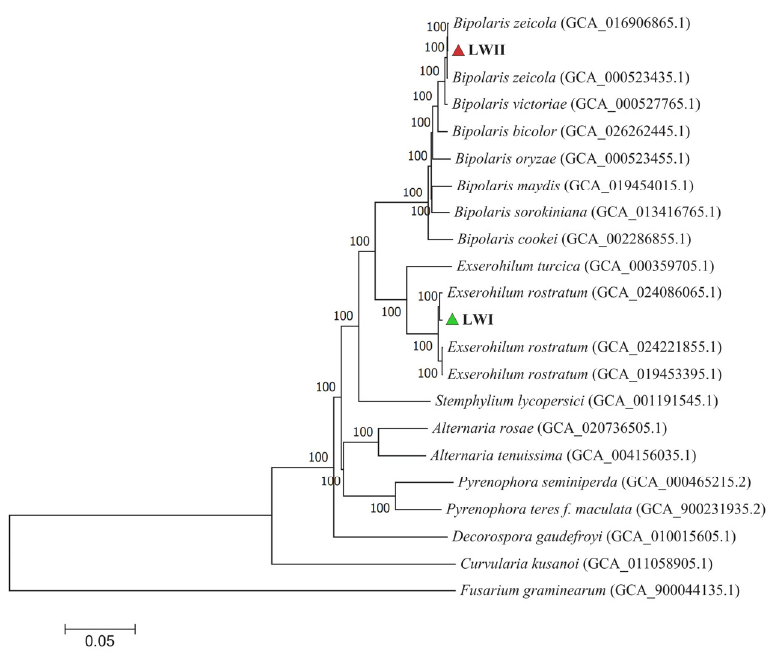
Figure 10. The phylogenetic relationship between E. rostratum LWI and B. zeicola LWIIwas constructed based on phylogenetic trees of the gene family analysis. There were 2072 single-copy homologous genes. The Bootstrap value indicates the confidence level of the branch in the phylogenetic tree. The triangular symbols indicate the positions of E. rostratum LWI (green) and B. zeicola LWII (red), and the information in parentheses indicates the gene assembly